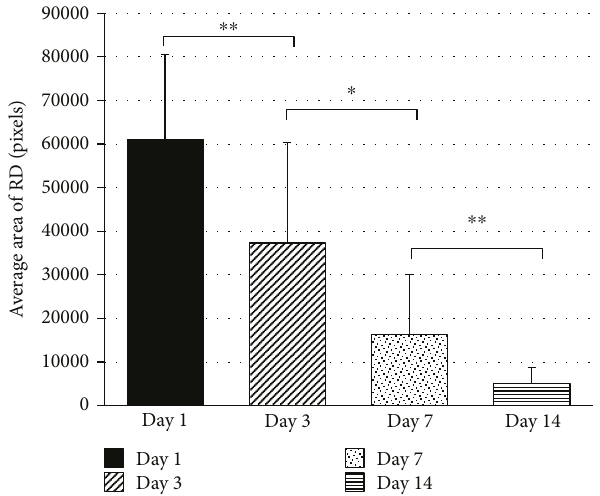
Figure 2: Illustration of the area of the detachment at di ff erent time course. ∗ Statistically signi fi cant, p < 0 01 . ∗∗ Highly statistically signi fi cant, p < 0 005